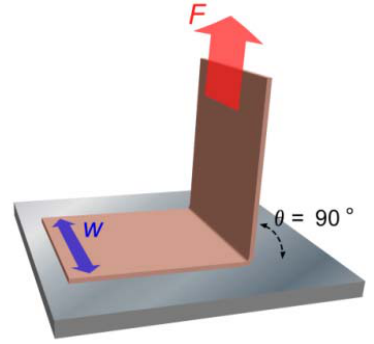
Fig. 1 Schematic diagram explaining the principle of the ninety-degree peel test. A cell sheet is peeled off from the culture substrate at 90 ° to measure adhesion force.